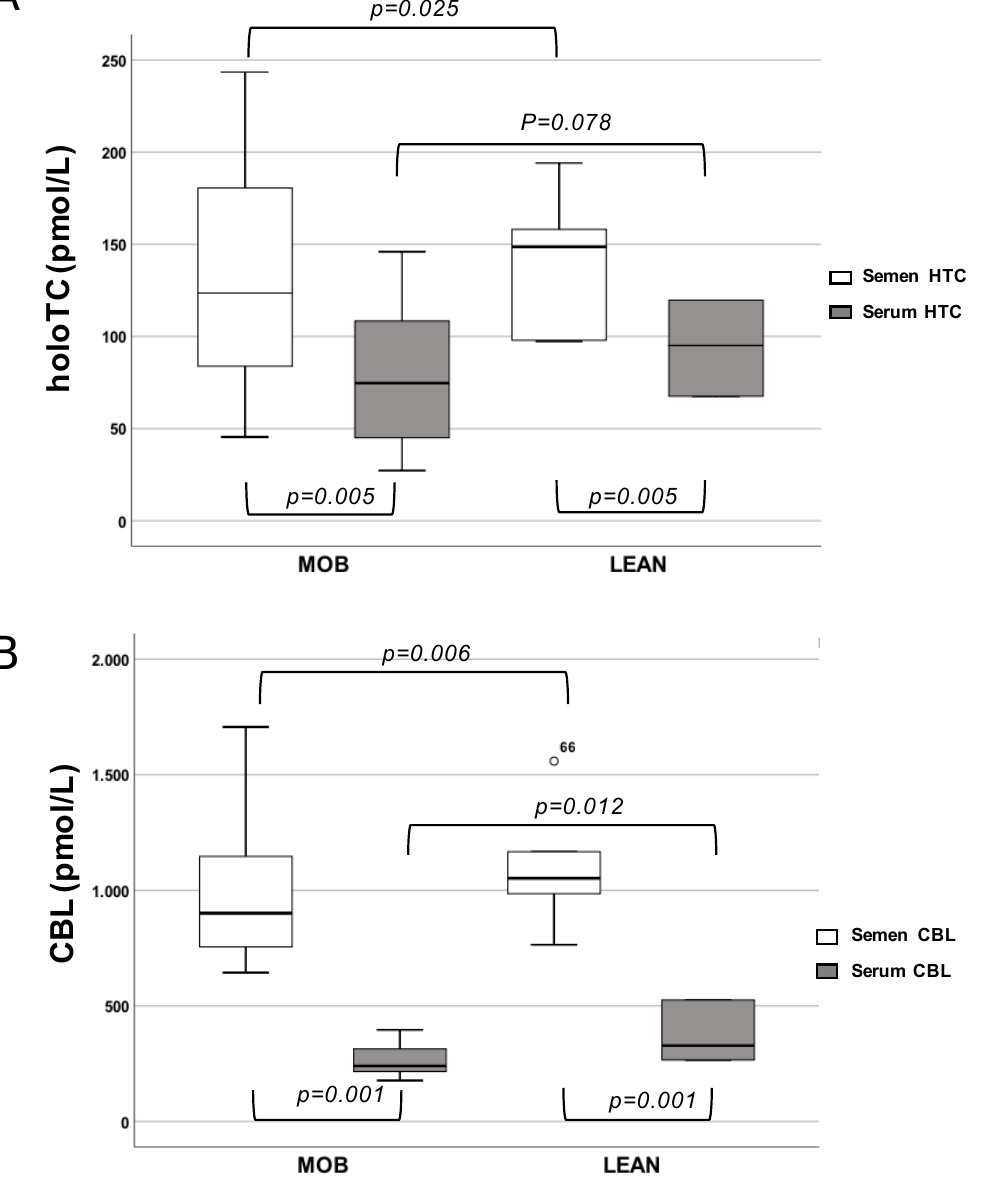
Figure 2. CBL and holoTC concentrations in serum and seminal samples from morbidly obese and lean subjects. Data is not-normally distributed and reported as box charts for holoTC ( A ) and CBL ( B ) serum and semen concentrations ; p derived from the Mann-Whitney U test analysis is indicated. MOB: morbidly obese subjects; LEAN: lean subjects.